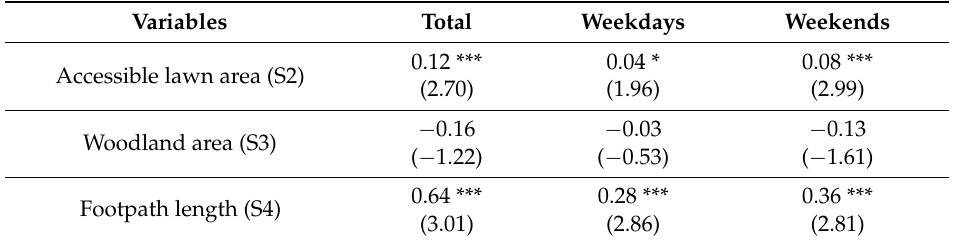
Table 4. Dummy-variable model (model